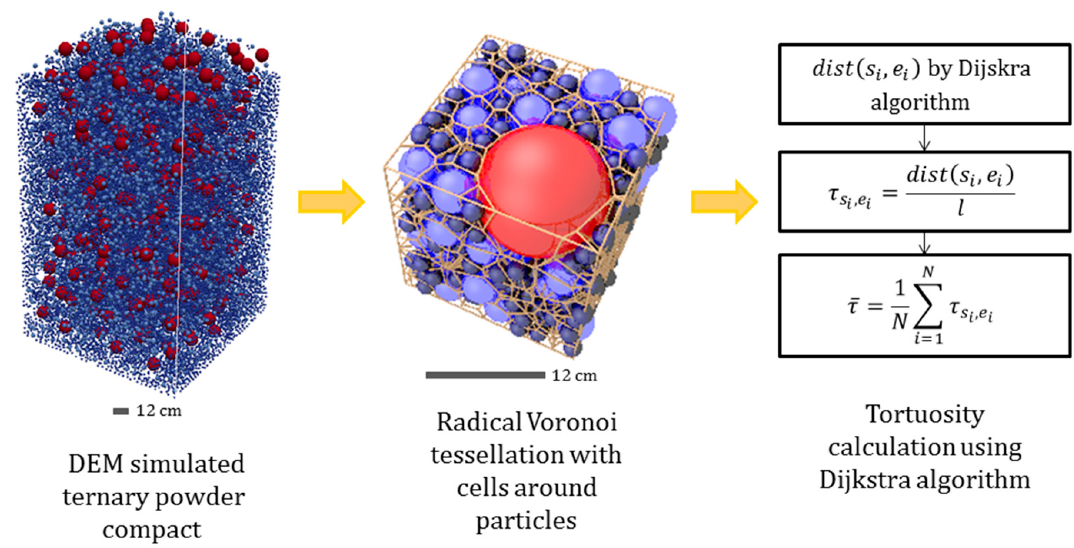
Figure 1. Schematic diagram for calculation of tortuosity. Here, 𝑑𝑖𝑠𝑡(cid:4666)𝑠 (cid:3036) ,𝑒 (cid:3036) (cid:4667) is the length of the shortest path between pairs of starting 𝑠 (cid:3036) and ending 𝑒 (cid:3036) vertices lying on the opposite faces of the is the tortuosity calculated for each vertex pairs 𝑠 (cid:3036) and sample box. l is the Euclidean distance. 𝜏 (cid:3046) (cid:3284) ,(cid:3032) (cid:3284) 𝑒 (cid:3036) . 𝜏̅ is the mean tortuosity, 𝑁 is the total number of tortuosity